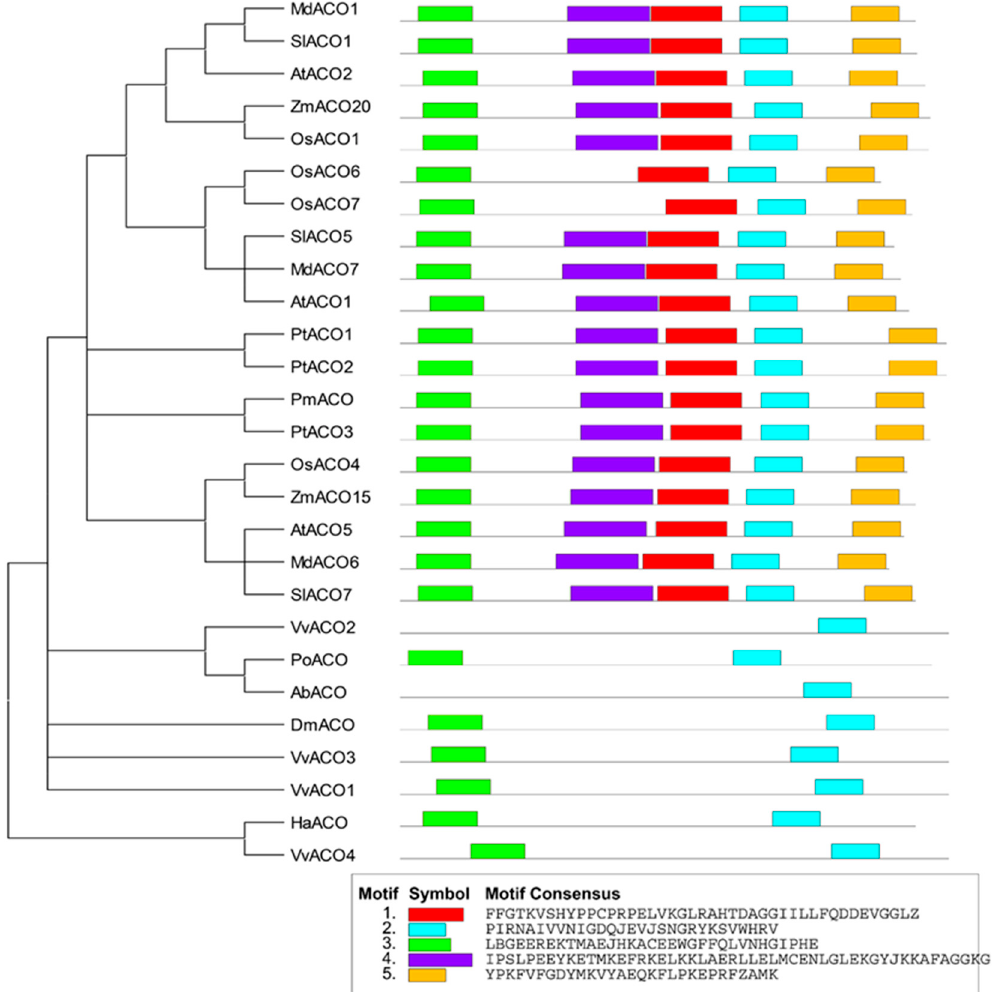
Figure 5. The phylogenetic relationships and conserved motif structure of the ACO protein sequences from the functional ACOs of fungi, slime molds and angiosperms plants, and the putative functional ACOs of cyanobacteria and gymnosperms. The phylogenetic trees were constructed MEGA version 11.0 with the maximum likelihood method. The conserved motif structure was discovered by MEME. The protein sequence information listed in Table 2.